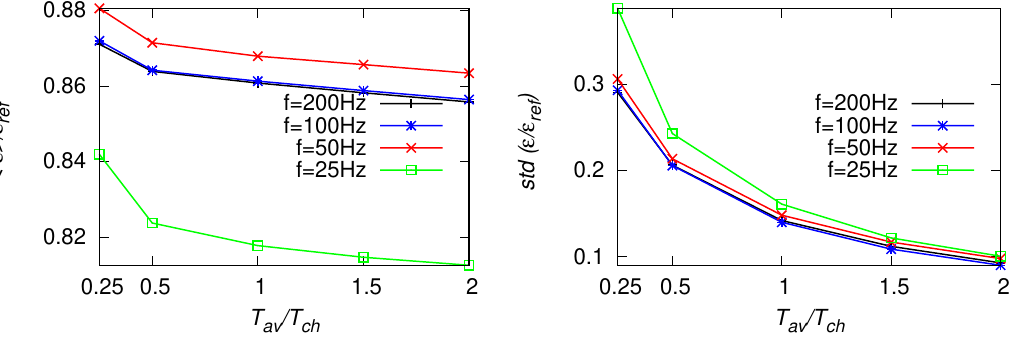
Figure 11. As in Figure 10, but for the fitting range f = [ 5 ÷ 10 ]